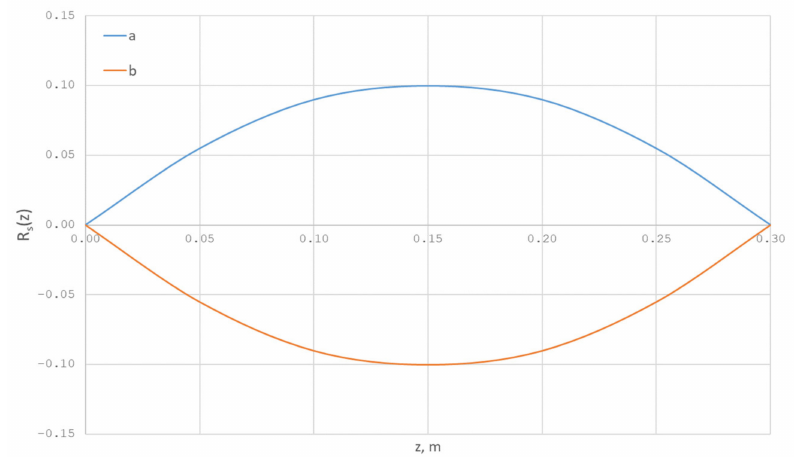
Figure 18. Deviation of the fiber radius (in fractions of the stationary solution).